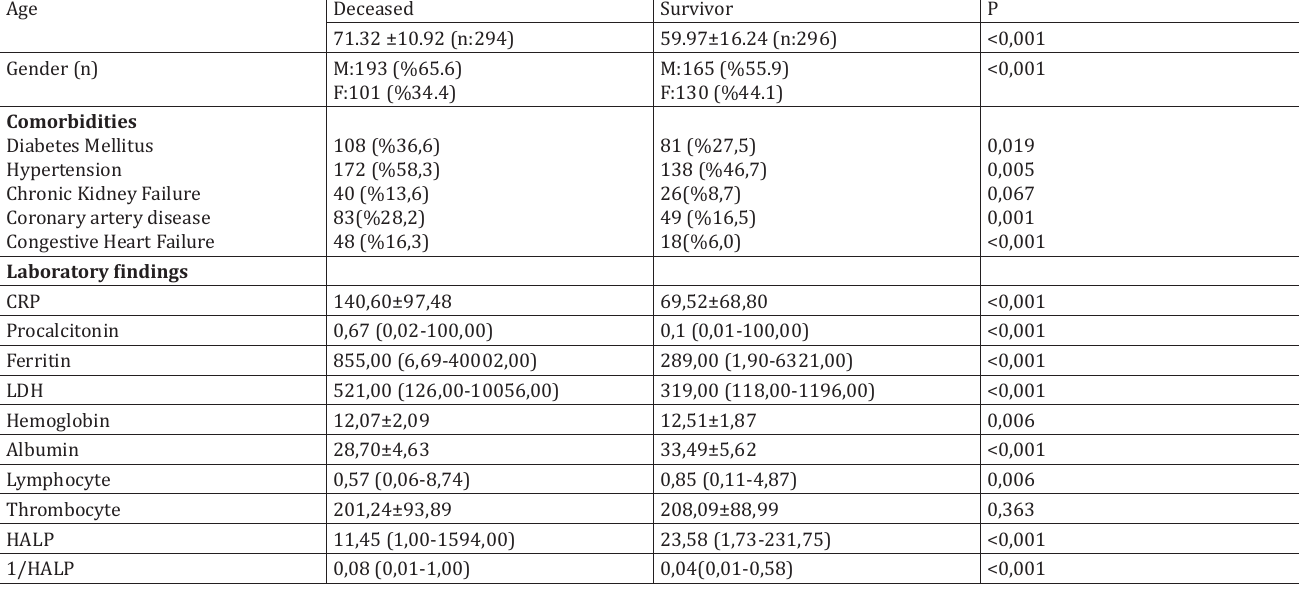
Demographics and comparison of laboratory findings in deceased and survivor